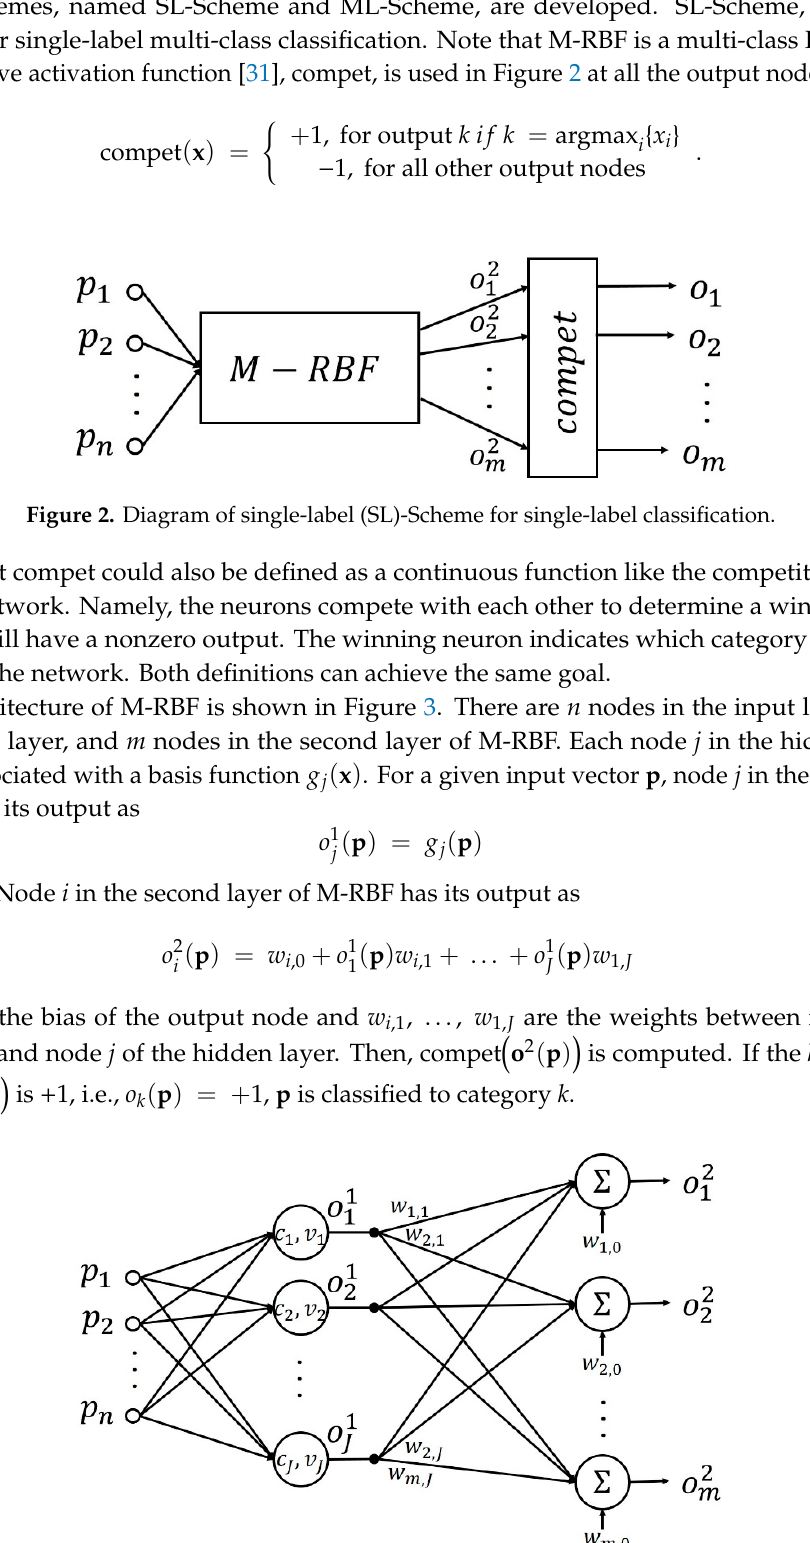
Figure 3. Multi-class radial basis function (RBF) network M-RBF.